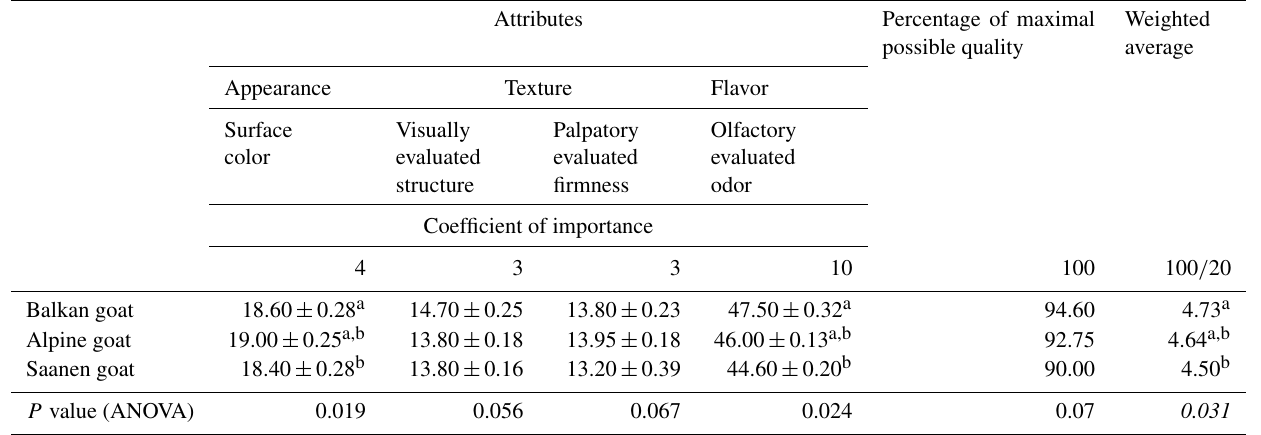
Weighted possible quality average